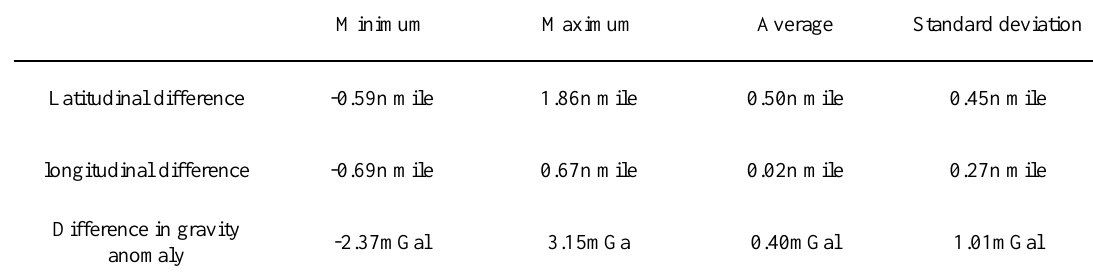
(c) Figure 2 . Matching results of track I Table 2 .The accuracy of matching navigation